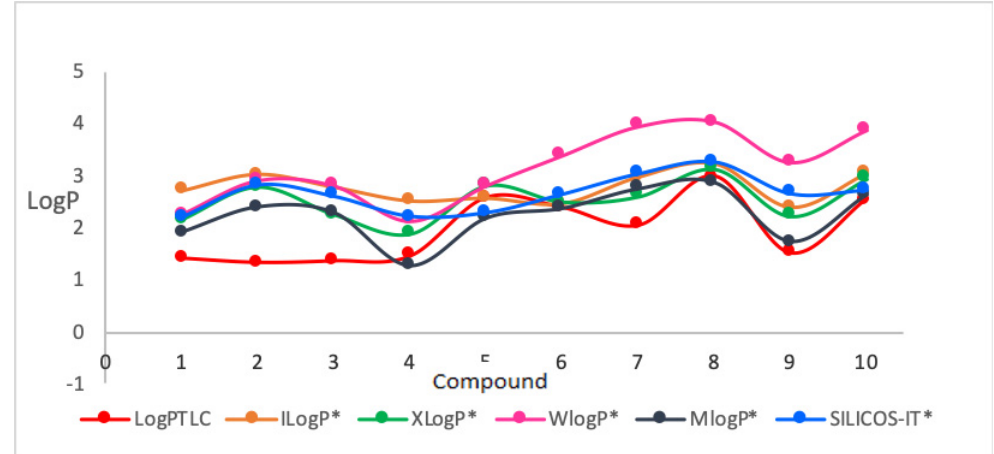
Figure 4. Graphical visualization of the calculated log P values (using SwissADME models) of the tested compounds with a comparison to log P TLC.